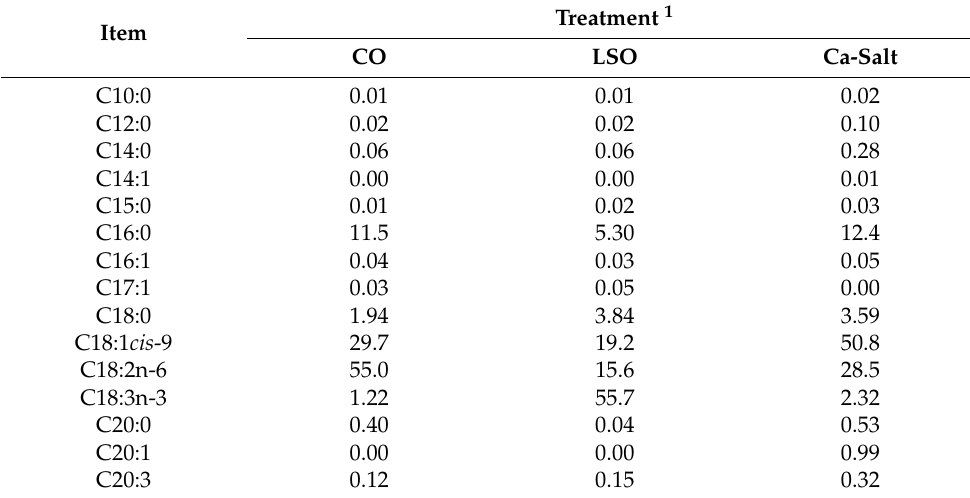
Table 1. Fatty acid compositions of oil sources (% total fatty